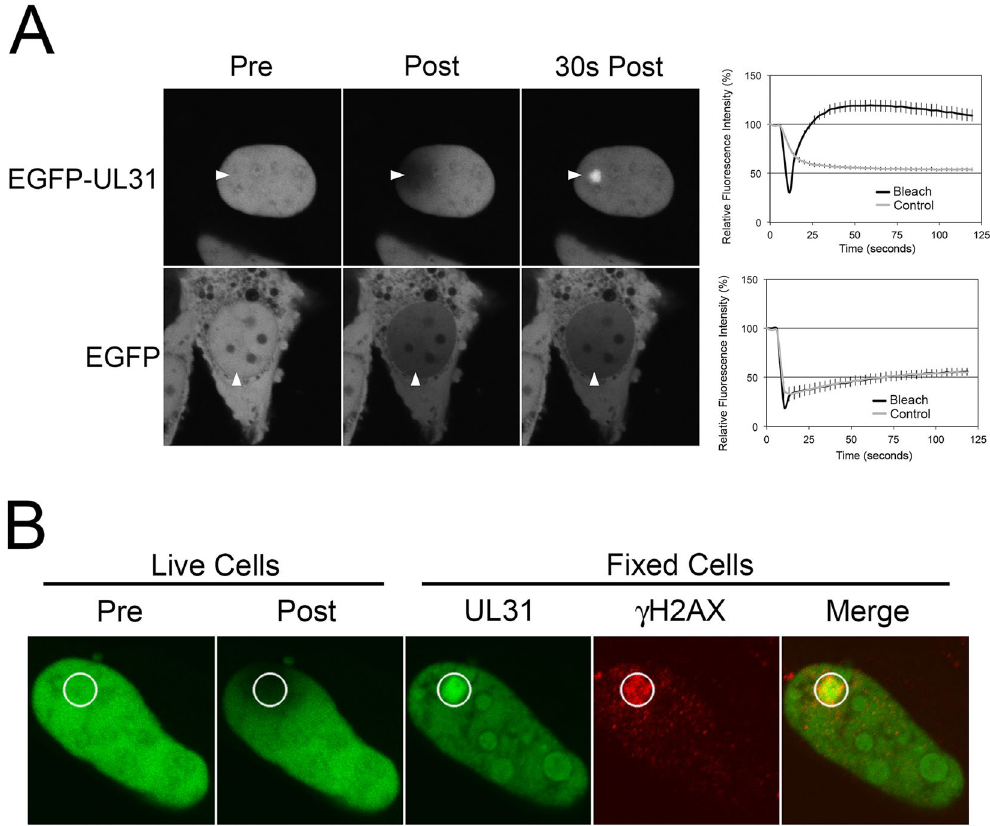
Figure 1. UL31 accumulates at sites of laser microirradiation-induced DNA-damage. ( A ) Representative images of live HeLa cells transfected with EGFP or EGFP-UL31 expression plasmids immediately before (Pre), immediately after (Post), and 30 seconds after the areas indicated by the arrowheads were microirradiated with a 405 nm laser using an Olympus FV1000 laser-scanning confocal microscope. The graphs display quantitation of the average fluorescence intensity of the microirradiated area (Bleach), as well as control distal areas (Control), over time for n = 20 cells in four independent experiments for EGFP-UL31 and for n = 22 cells in three independent experiments for EGFP. Error bars are standard error of the mean. ( B ) Images of a live HeLa cell transfected with EGFP-UL31 on grid-bottom dishes immediately before, and immediately after the indicated area (white circle) was microirradiated with a 405 nm laser using an Olympus FV1000 laser-scanning confocal microscope (Live). Cells were immediately fixed and stained with anti- γ H2AX antibody followed by staining with Alexa 568 conjugated donkey anti-mouse secondary antibody. Microirradiated cells were relocated and images captured by confocal microscopy (Fixed). Image is representative of n = 8 cells analyzed in two independent